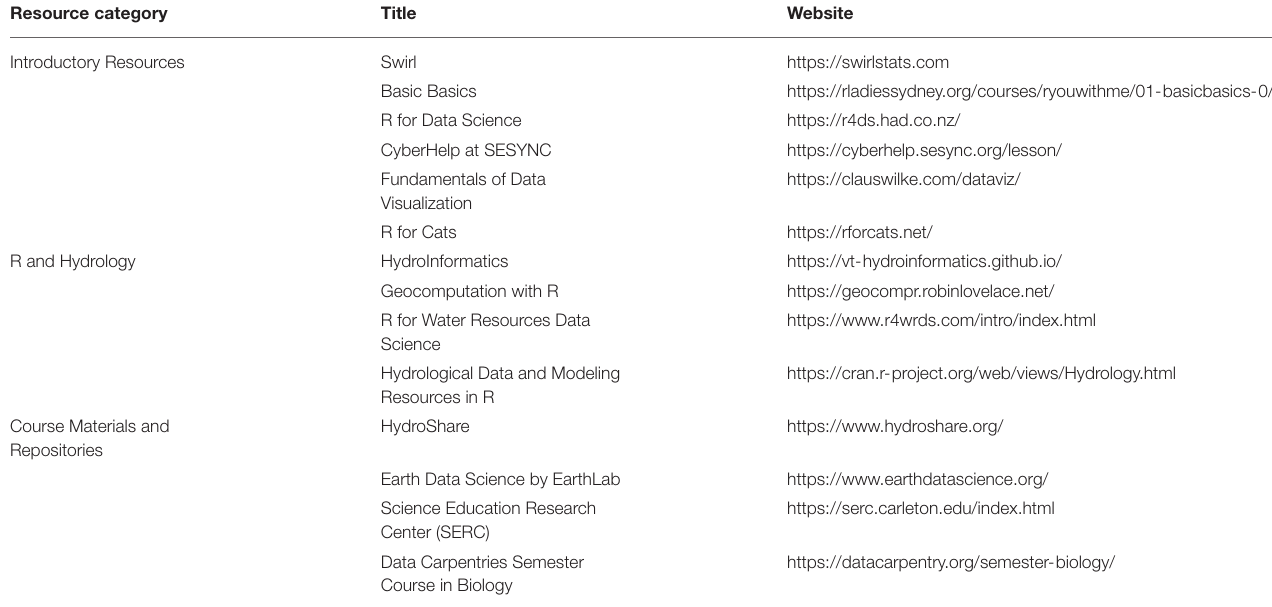
TABLE 1 | Freely available resources that can be used to incorporate coding into hydrology courses. Resource